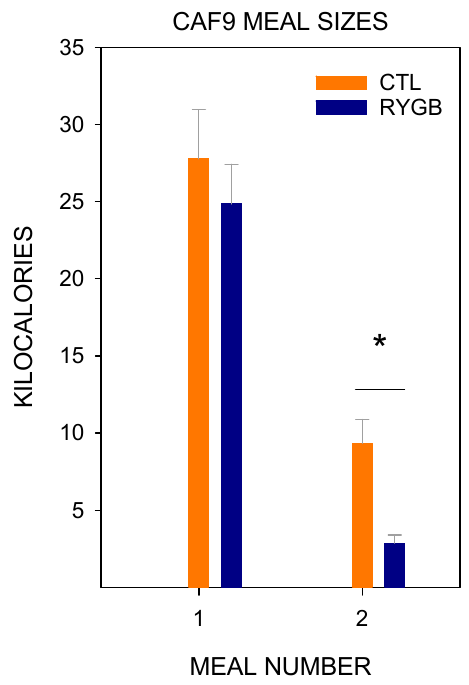
Figure 17. Energy Consumed in the First and Second Meal of Cafeteria Diet Postsurgically. Mean (±SE) meal size (in kcal) for Control (CTL; combined SHAM and IRON groups, n = 14) and RYGB ( n = 11) rats. *: Significant results ( p < 0.05) from two-sample t -tests.